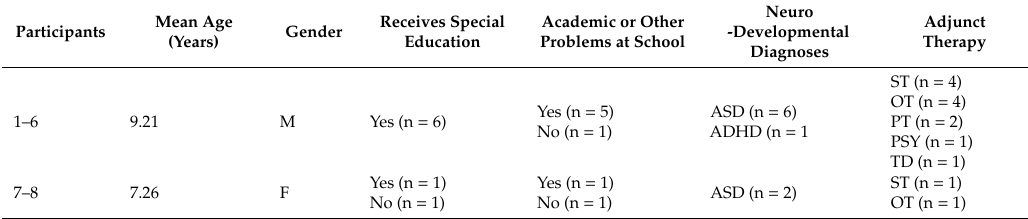
Table 1. Participant characteristics by